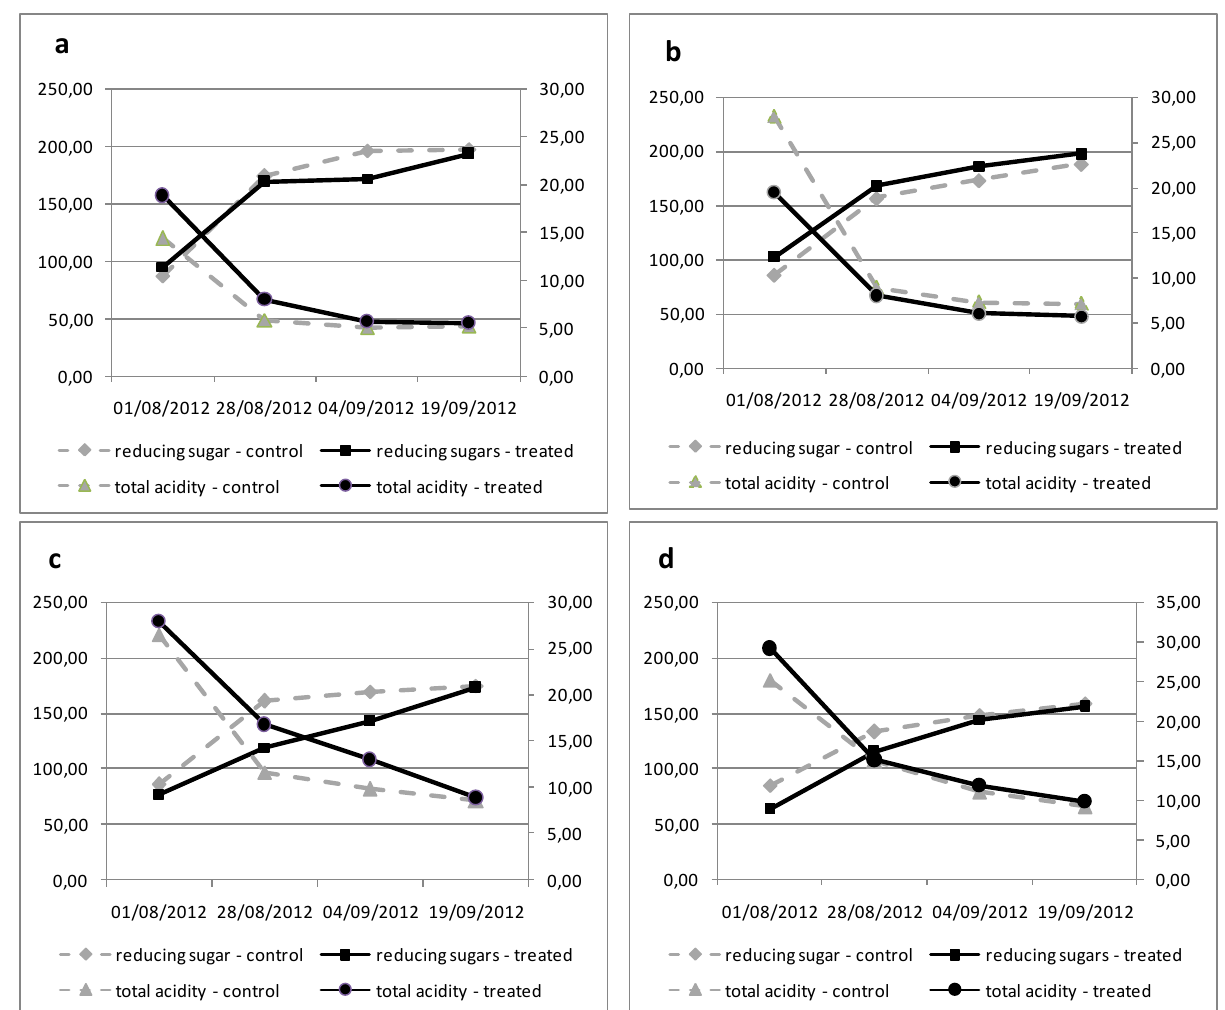
Figure 3. Maturation curves, in 2012, of total berry sugars and total berry acids from healthy (a), asymptomatic (b) and symptomatic [asymptomatic (c) and symptomatic (d) shoots] grapevines affected by GLSD, at four growth stages: ‘Beginning of ripening: berries start to develop variety-specific colour’ (81); ‘Berries developing colour’ (83); ‘Softening of berries’ (85); and ‘Berries ripe for harvest’ (89).